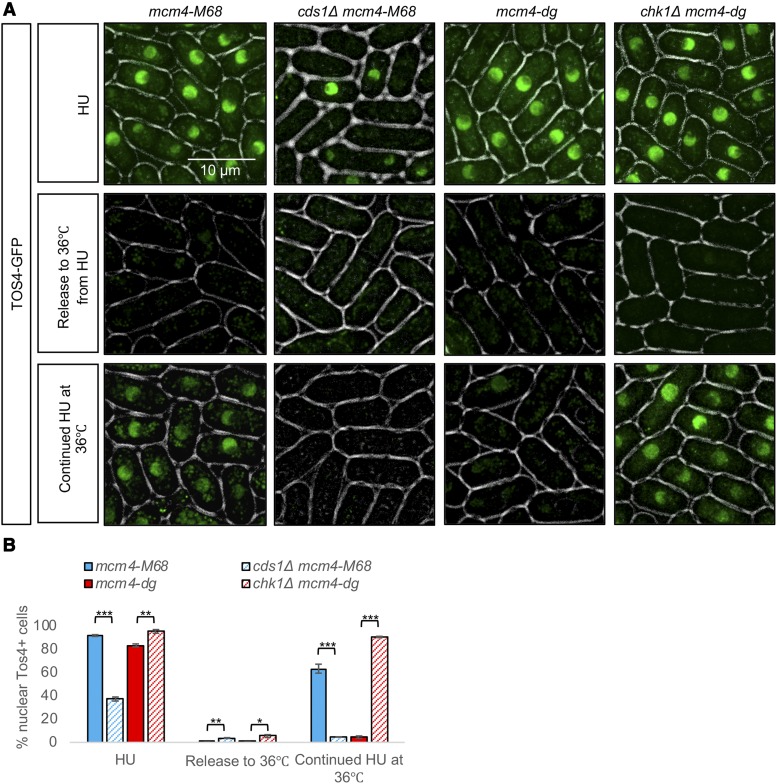
Continued Cds1 activation induces S phase arrest in mcm4-M68 but not mcm4-dg. (A) mcm4-M68, cds1Δ mcm4-M68, mcm4-dg, chk1Δ mcm4-dg were imaged for Tos4-GFP after treatment with 12 mM HU at 25°C, after release from HU to 36°C, or after pre-treatment with HU at 25°C then transfer to 36°C. (B) Quantification of % cells with nuclear Tos4-GFP in (A). N> 300 cells analyzed for each strain. A two-tailed Student’s t-test was used to determine significance: * P < 0.05, ** P < 0.01, *** P < 0.001, Error bars represent Standard Error (SE).